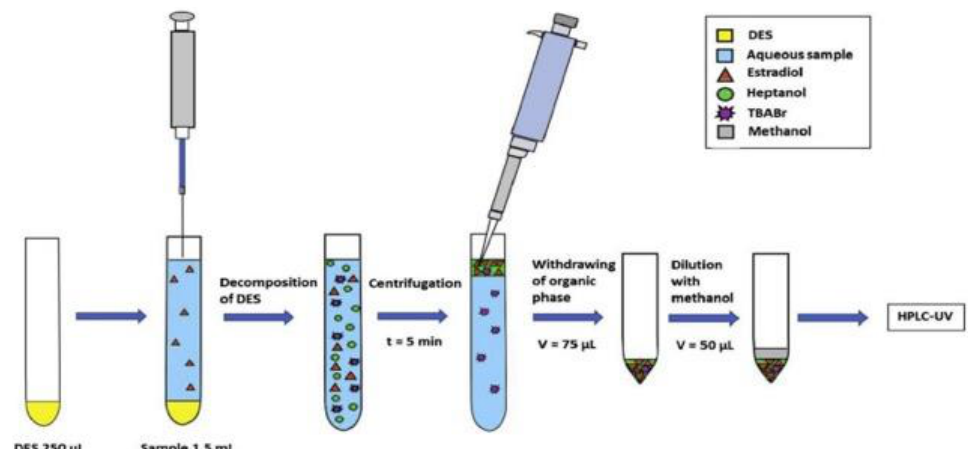
Figure 4. Schema of liquid-liquid microextraction based on in situ decomposition of deep eutectic solvent. Reproduced with permission from [62], Copyright Elsevier, 2019.